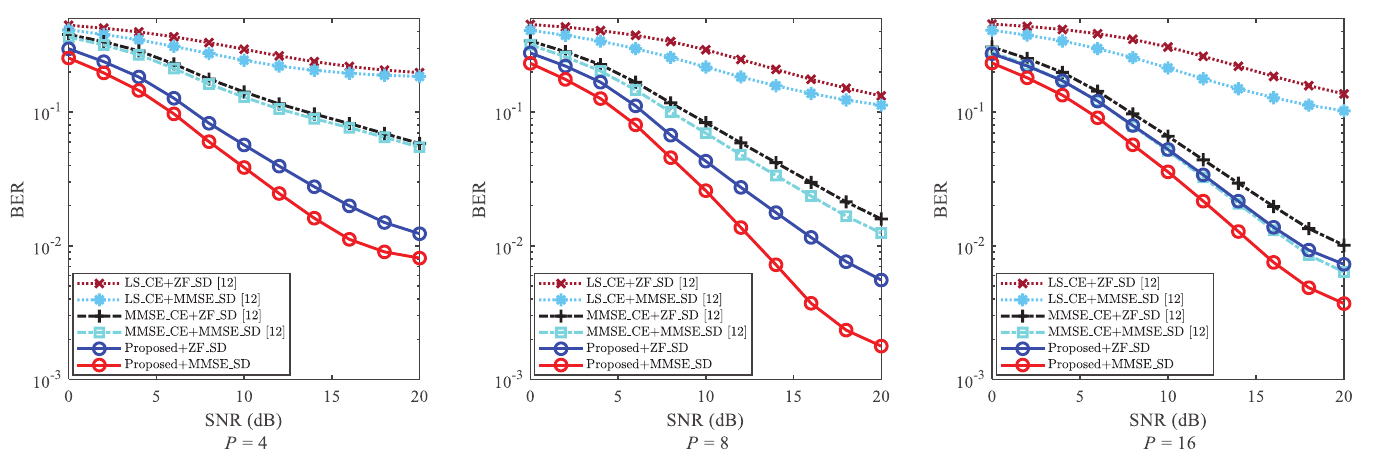
Fig 6. BER of SD against the impact of P , where P = 4, P = 8 and P = 16 are considered, respectively.